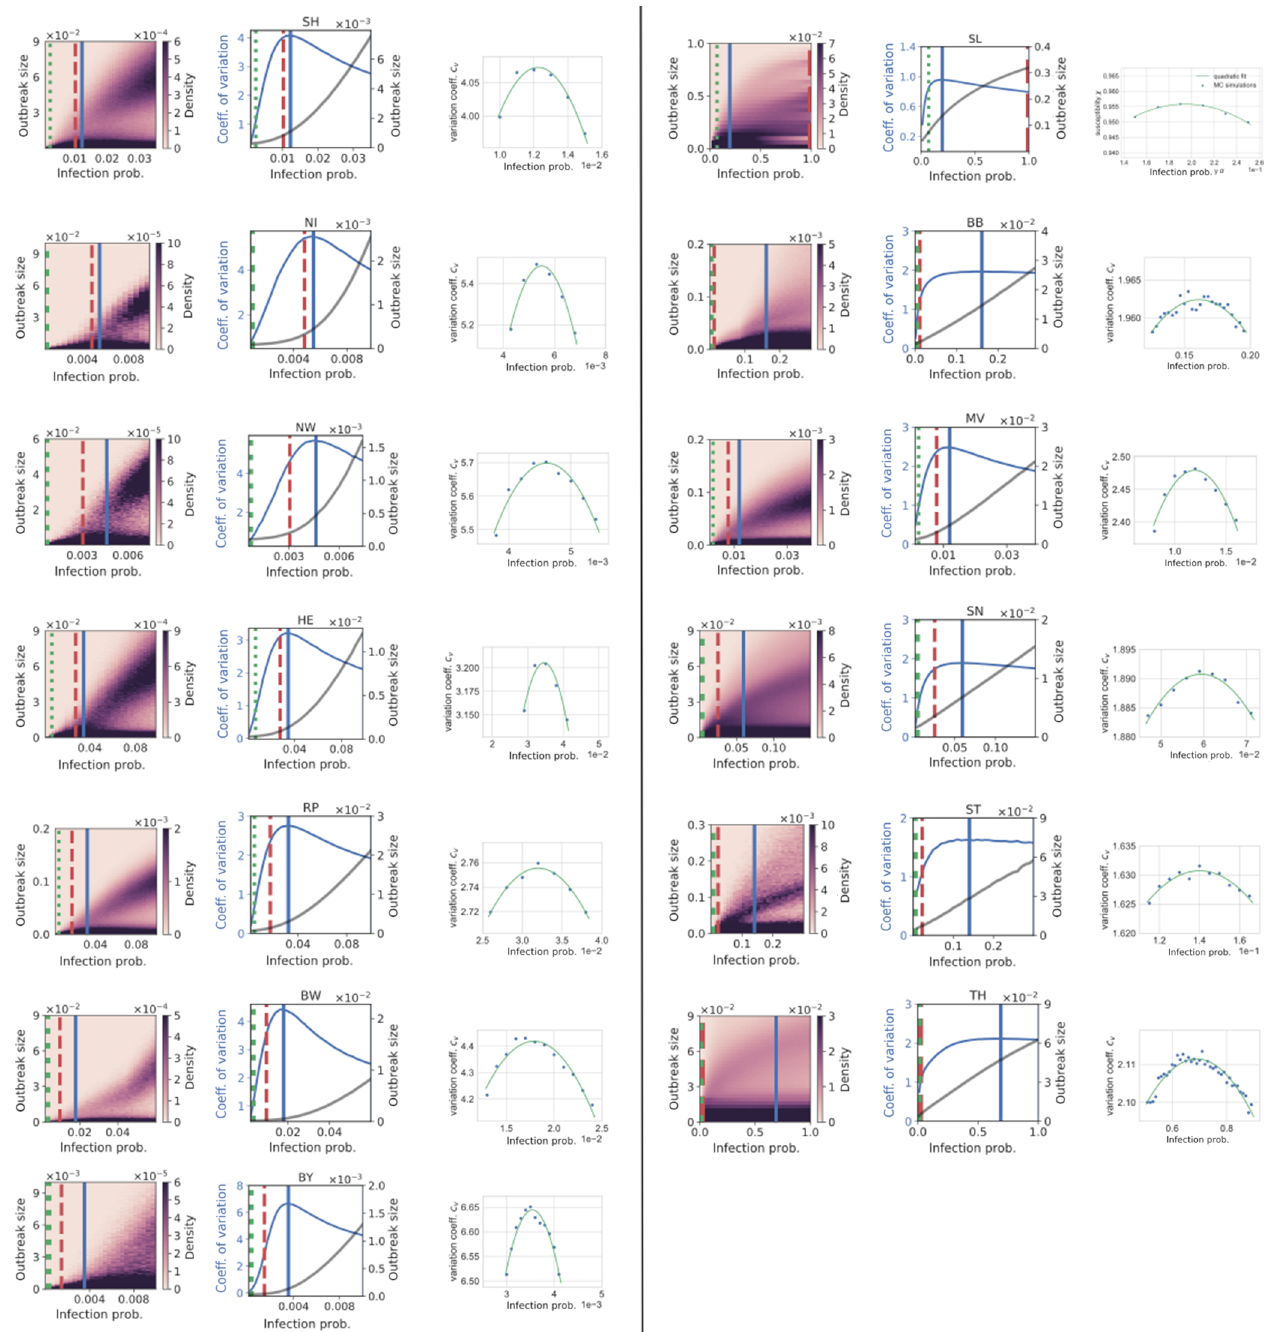
FIG. 20. Detailed analysis of the epidemic threshold for the cattle-trade network with μ ¼ 1 = 120 . The analysis is akin to Fig.